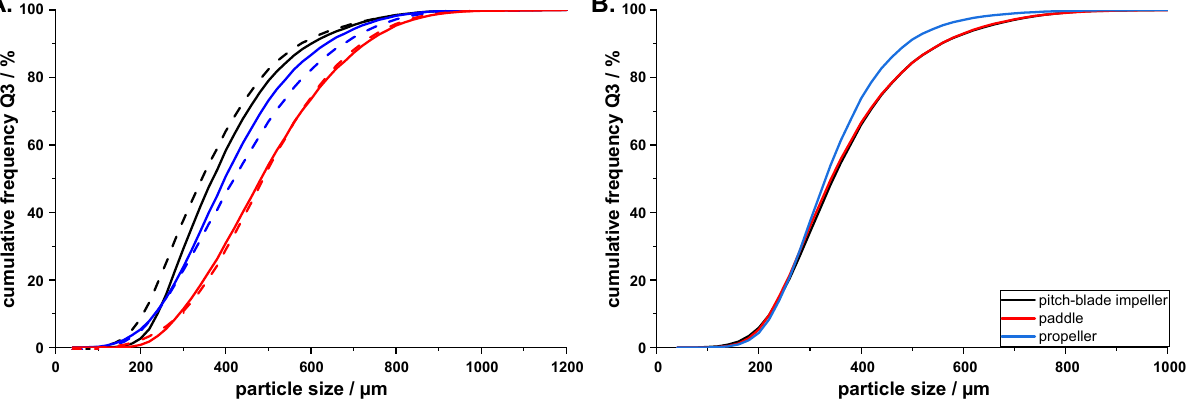
Figure 7. ( A ). PSD of three different QESD MF agglomerate batches before (dotted line) and after (solid line) passing through a peristaltic pump ( n = 1, entire batch); ( B ). PSD of QESD MF agglomerates produced with different stirrer types under constant conditions ( V 0 = 300 g, 𝑉(cid:4662) (cid:2925)(cid:2931)(cid:2930) = 23.8 mL/min, 300 rpm, n = 1, entire batch).